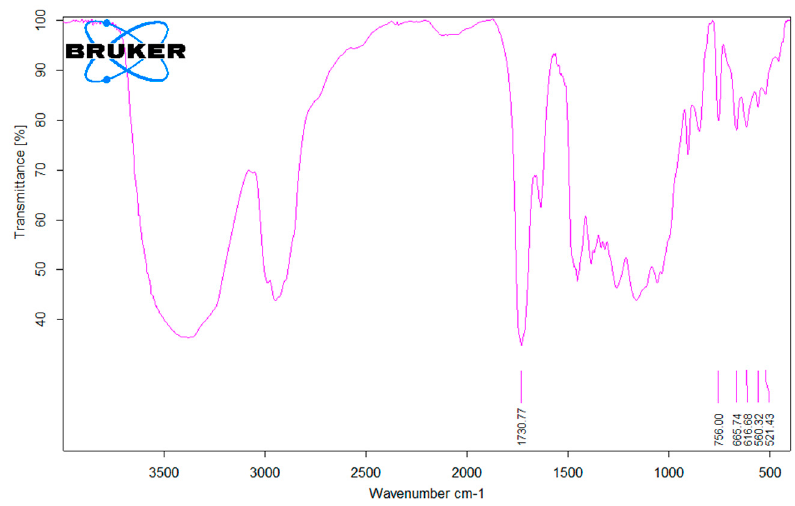
Figure 12. BNC-GMA-EGDMA MS = 1 FT–IR spectrum.